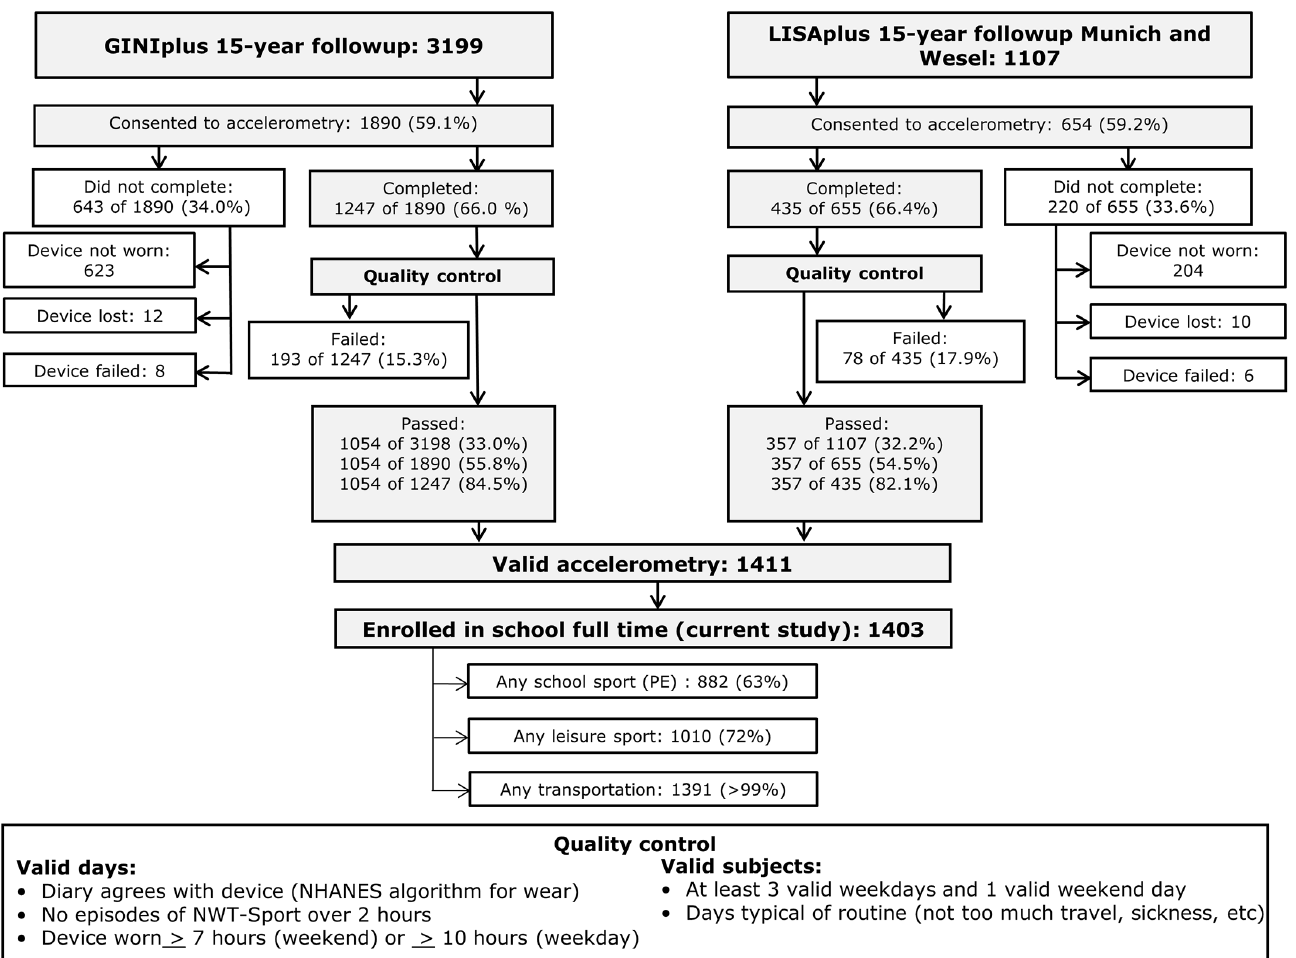
Fig 1. Accelerometry Response Rate. GINIplus15 and LISAPlus15 are the 15-year followups of birth cohorts GINIplus and LISAPlus. For details on GINIplus and LISAplus see von Berg et al, 2003 and 2015 [24 – 26]and Chen et al, 2007 [19] respectively. We give the number and percentage of subjects as a percentage of those contacted for accelerometry, those who gave their consent, and those who completed accelerometry and returned the device. Quality control failure includes inconsistency between diary and weartime criteria of Troiano et al, 2007 [27] using SAS programs published by NHANES [28](58% of excluded days); other non-wear time issues (27% of excluded days); and technical issues (7.4% of excluded days). Many days were invalid for more than one